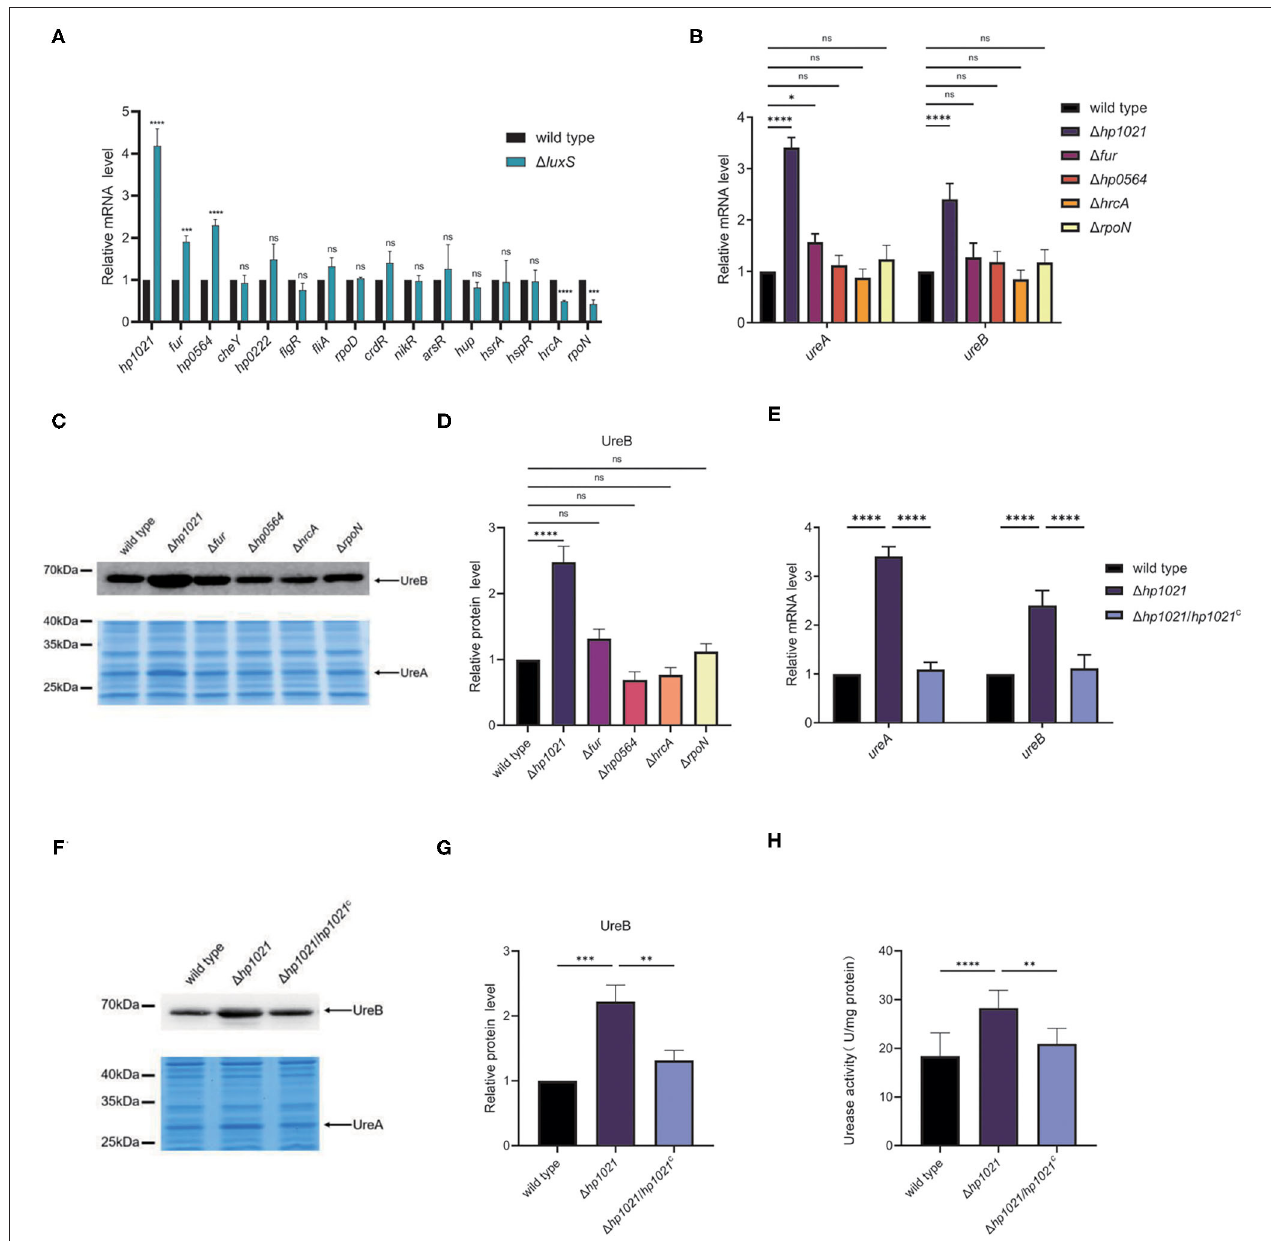
FIGURE 3 | HP1021 inhibited urease expression while AI-2 downregulated HP1021 expression. (A) The mRNA expression levels of transcriptional regulators determined by qPCR. (B) The mRNA expression levels of UreA and UreB regulated by transcriptional regulators, as determined by qPCR. Relative RNA levels represent the mRNA levels in the mutant strains normalized to those in the wild type strain. Values represent averages of three biological independent experiments and bars represent standard deviations. (C) Expression of UreA and UreB proteins regulated by transcriptional regulators. UreB expression was detected by Western blotting, with the arrow indicating UreB protein bands. Expression of UreA was detected by SDS-PAGE followed by staining with Coomassie brilliant blue. The arrow indicates UreA protein bands. (D) Densitometric analysis of UreB protein bands. Total protein bands stained with Coomassie brilliant blue were used as loading control. (E) The mRNA expression of UreA and UreB regulated by HP1021. (F) Expression of UreA and UreB proteins regulated by HP1021. (G) Densitometric analysis of UreB protein bands. Total protein bands stained with Coomassie brilliant blue were used as loading control. (H) Determination of urease activity in cell lysates. Values represent averages of three biological independent experiments and bars represent standard deviations. **** P < 0.0001, *** P < 0.001, ** P < 0.01, * P < 0.05, ns, non-significant.